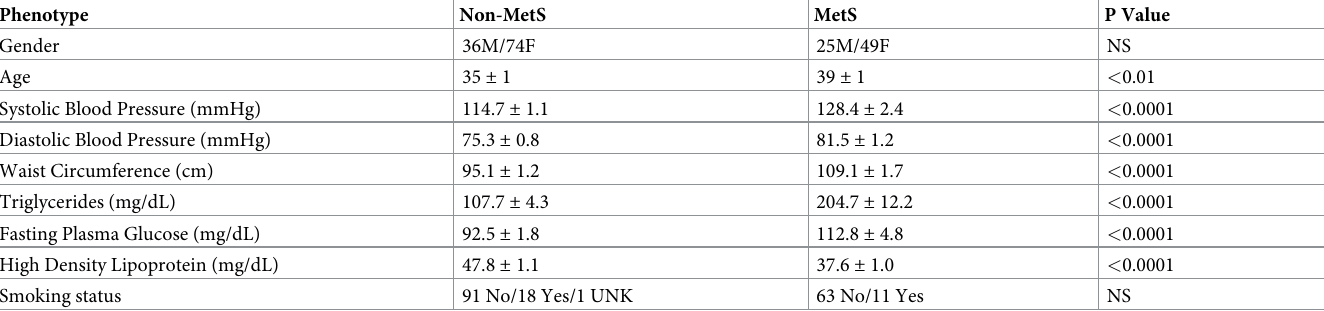
Table 1. Phenotypes from non-MetS versus MetS participants in the Arizona Insulin Resistance (AIR) registry.